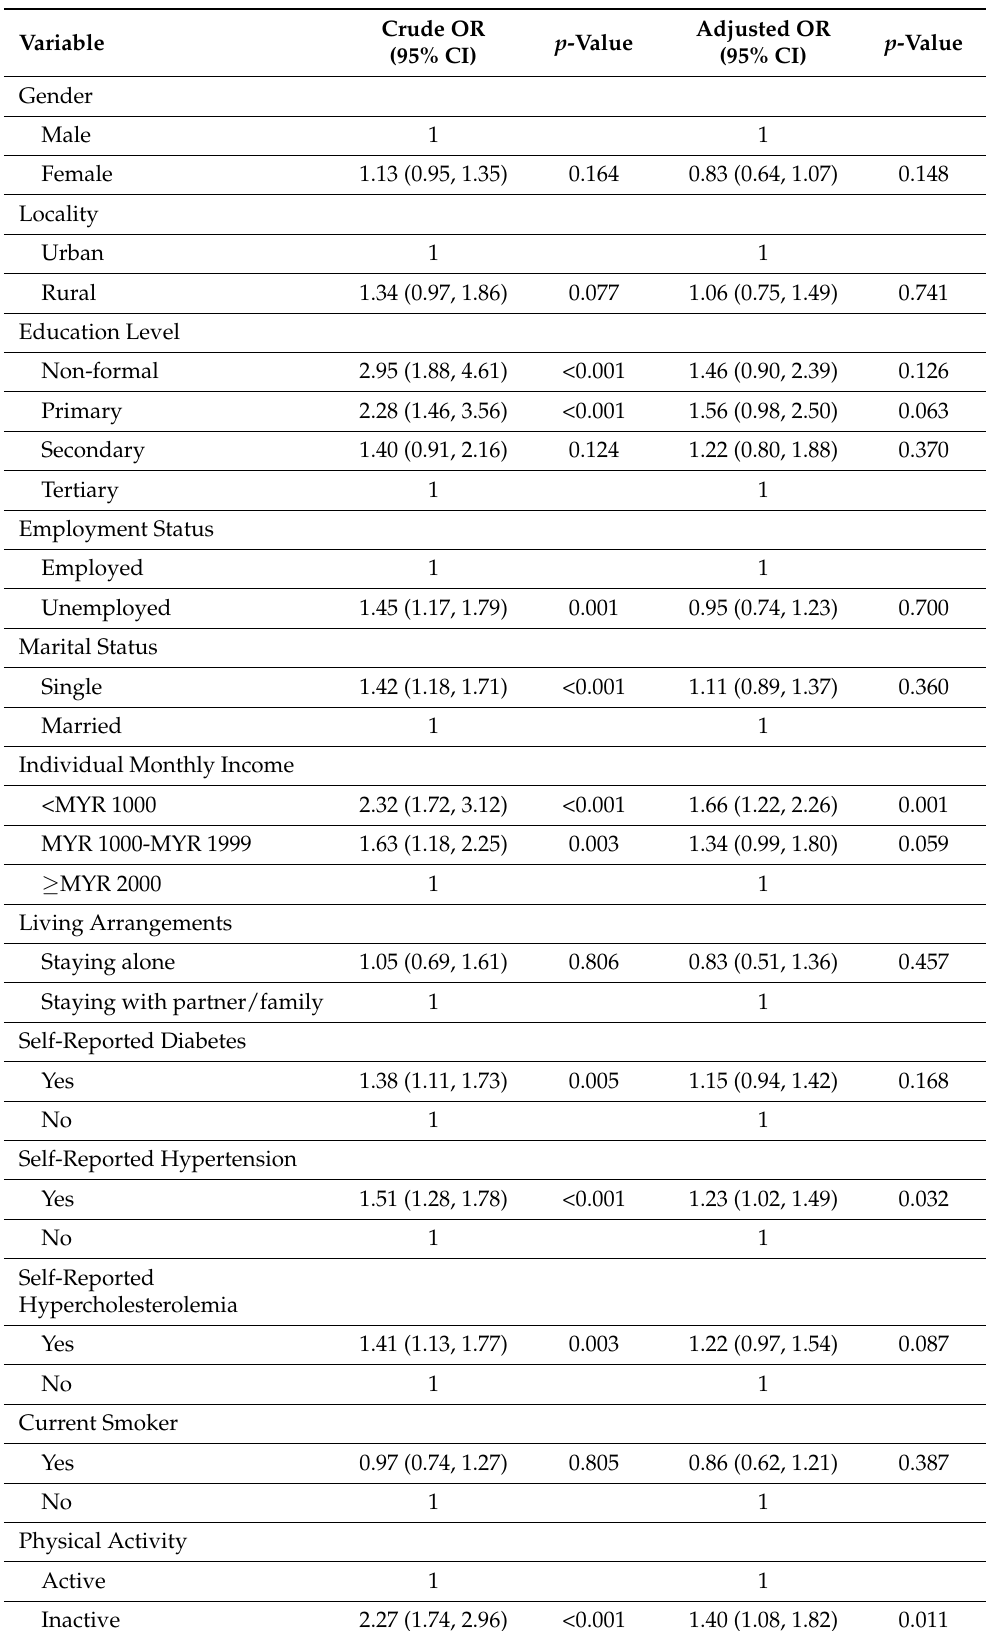
Table 3. Univariate and multivariate logistic regression analysis for poor self-rated health among Malaysian older persons aged 60 years above (n =